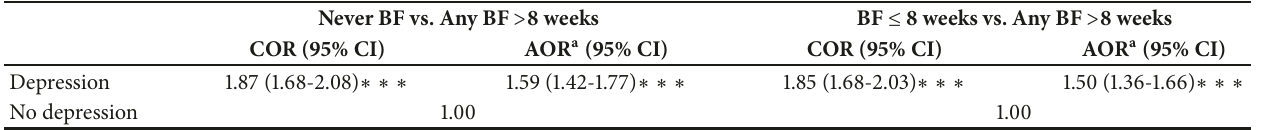
Table 2: Association between prepregnancy depression and breastfeeding duration.